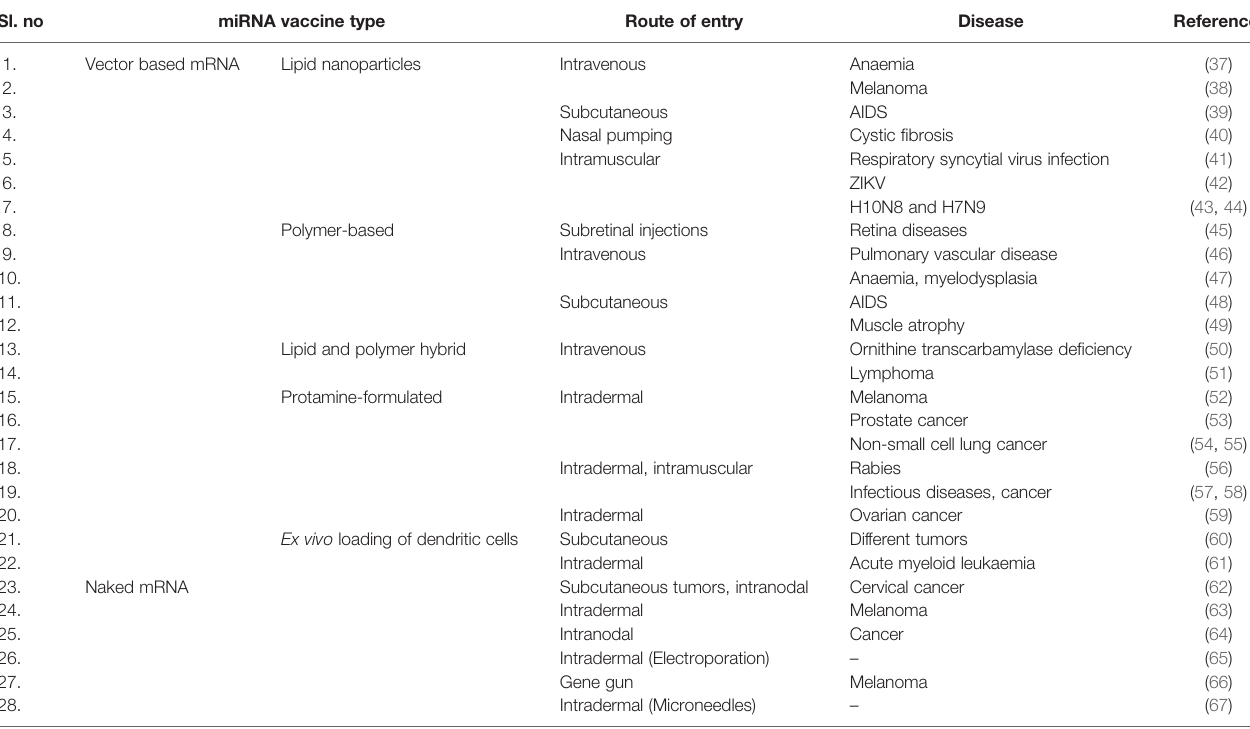
TABLE 1 | Different delivery system for the different type of mRNA vaccine. Sl.